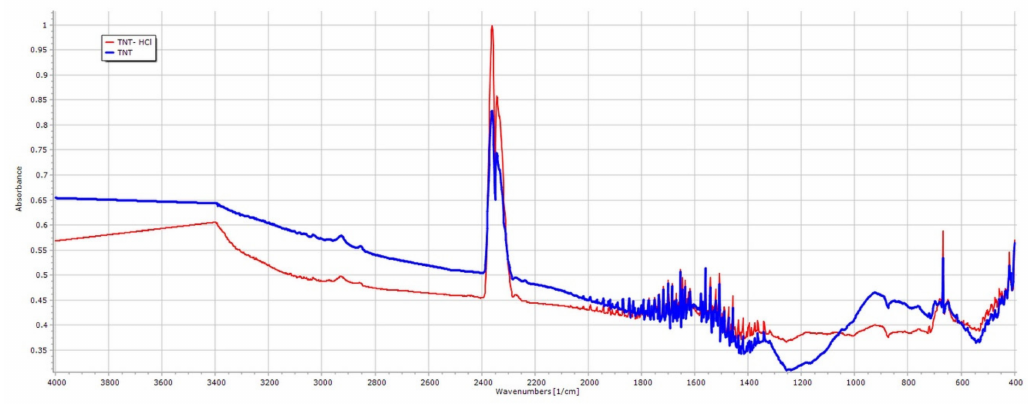
Figure 2. FT-IR spectra of TNTs and TNT–HCl 0.01 M.